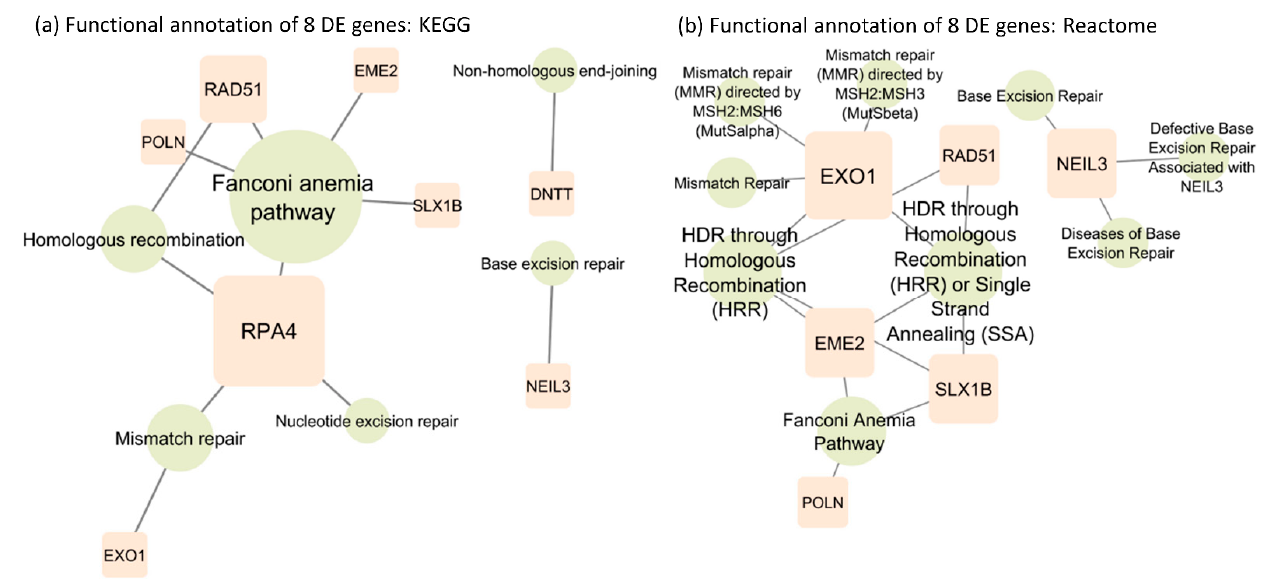
Figure 2. ( a ) Functional annotation of 8 SDE genes based on the KEGG database. ( b ) Functional annotation of 8 SDE genes based on the Reactome database.